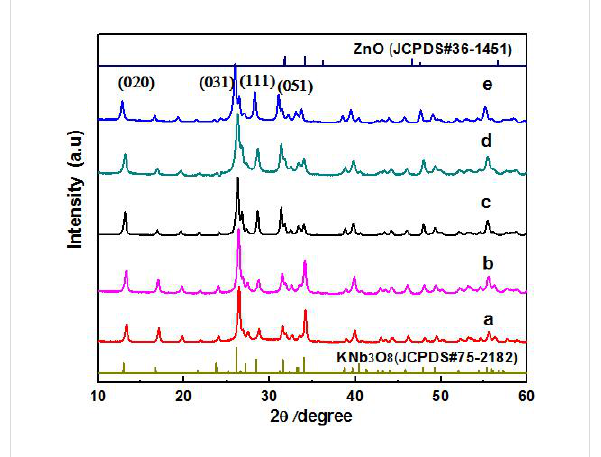
Figure 2: X-ray diffraction patterns of catalysts loaded with different amounts of ZnO quantum dots: (a) pure KNb 3 O 8 ; (b) 1 wt % ZnO–KNb 3 O 8 ; (c) 2 wt % ZnO–KNb 3 O 8 ; (d) 3 wt % ZnO–KNb 3 O 8 ; (e) 4 wt % ZnO–KNb 3 O 8 .